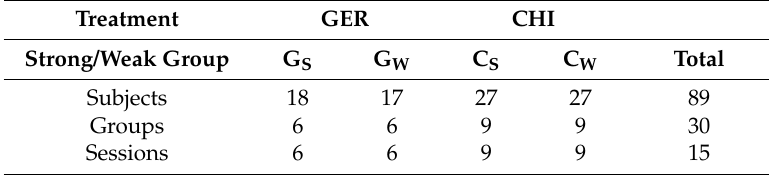
Table 1. Experimental treatments and